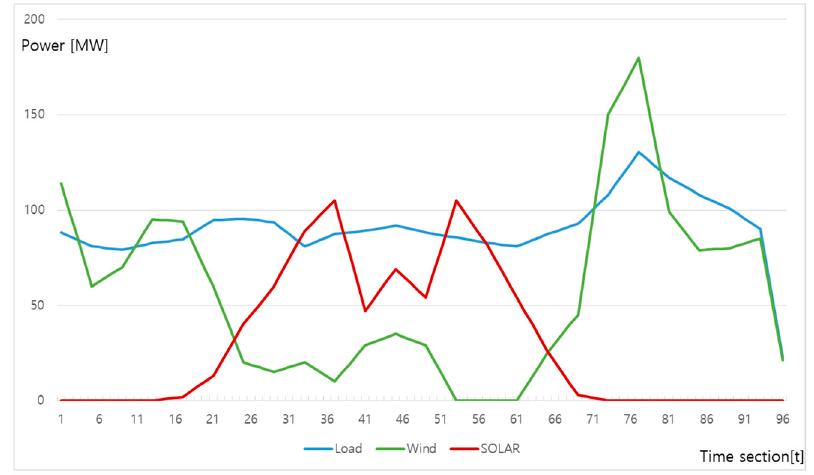
Figure 3. Input forecast data for case study.